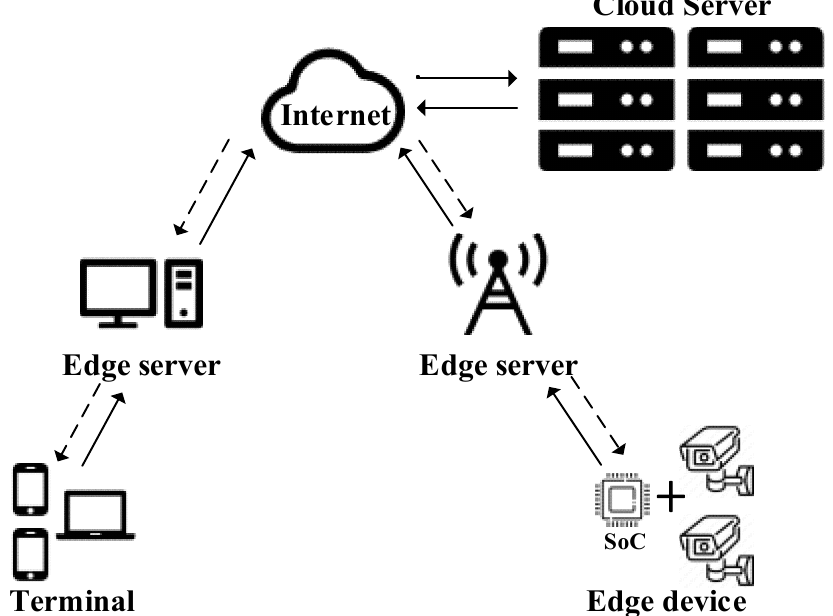
Figure 12. Edge computing-based video streaming analytics architecture.